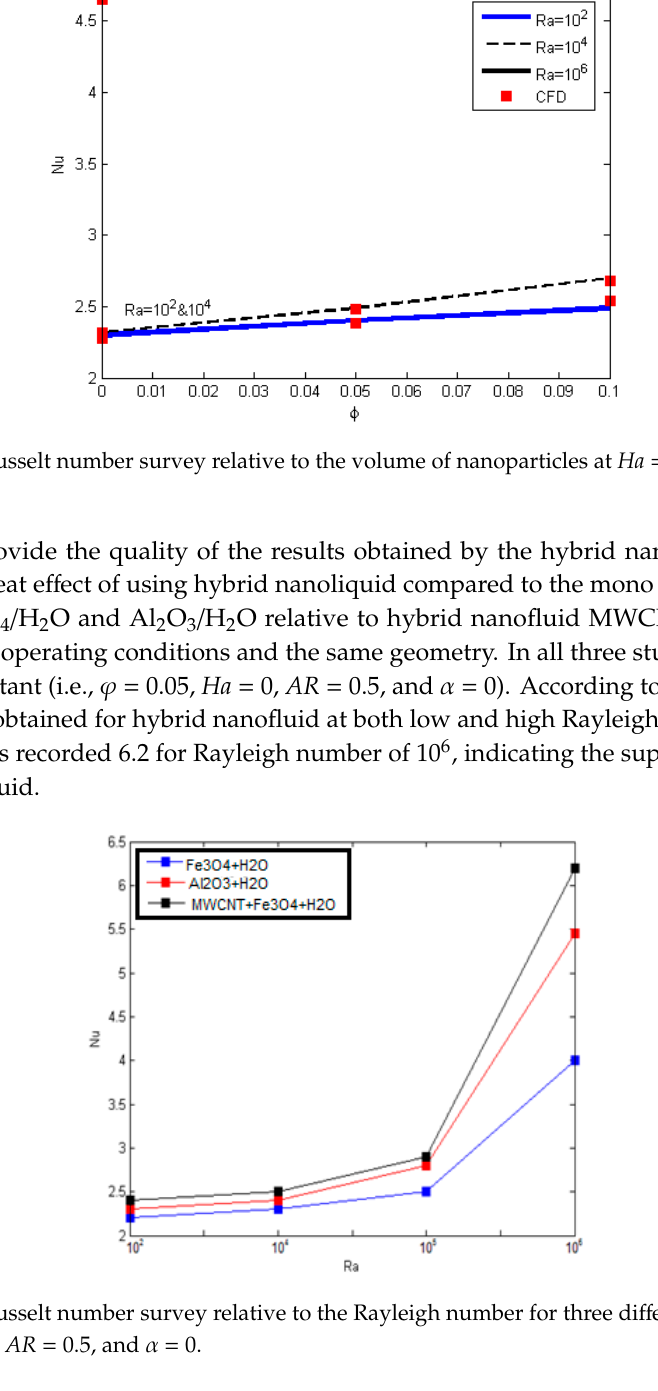
Figure 9. The Nusselt number survey relative to the Rayleigh number for three different nanofluids ϕ = 0.05, Ha = 0, AR = 0.5, and α = at φ = 0.05, Ha = 0, AR = 0.5, and α = 0.